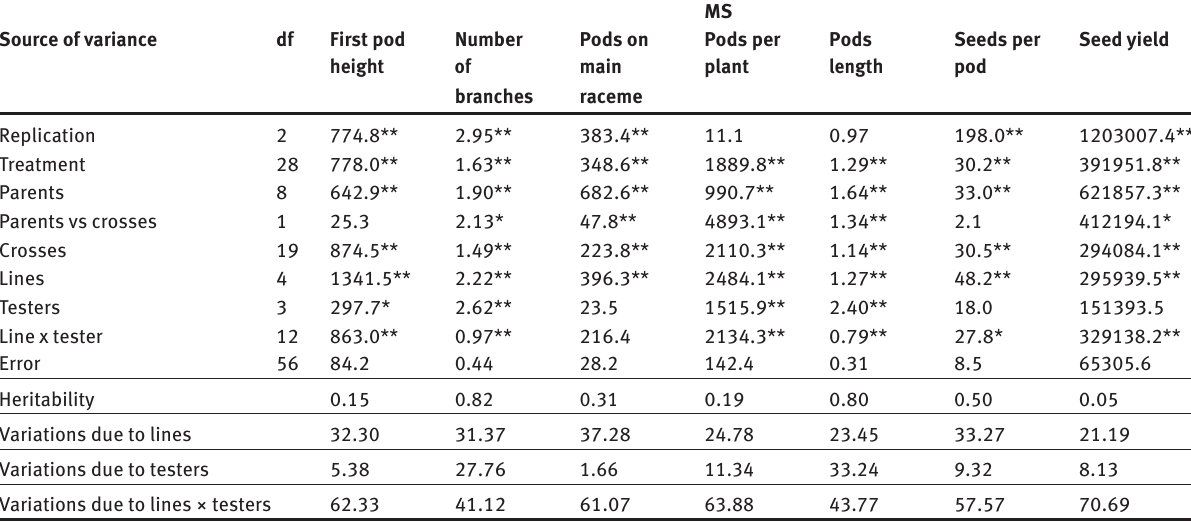
Table 1: Analysis of variance (ANOVA), narrow-sense heritability and component of variability for yield components and seed yield of rape-